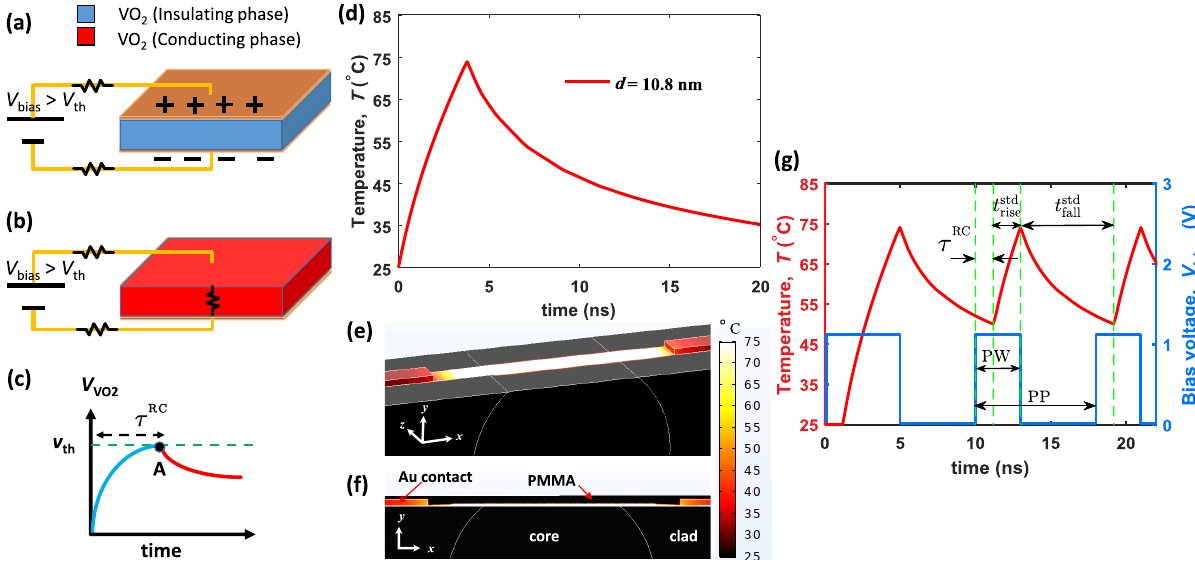
Figure 7: Modulation speed calculation. (a) The circuit model and phase-state of the device after applying the bias voltage before RC time < V ≥ V delay of the device, i.e. V , and (b) after RC time delay of the device, i.e. V . (c) The voltage-time diagram of the voltage on the VO 2 th VO 2 th VO layer after applying the bias voltage. (d) Temporal variation of the VO temperature between 25 ◦ C and 75 ◦ C during ICPT and CIPT for 2 2 d = 10 . 8 nm. (e) The 3D view of the spatial temperature distribution of the device at time = 4.2 ns. Here, PMMA is made transparent so that the temperature distribution of VO and Au contacts can be seen better. (f) 2D view of the device temperature distribution in the x − y plane. 2 (g) The steady-state operation of the TE modulator. The steady-state phase transition of VO and hence the switching between the on- and 2 off-states is induced by applying nanosecond electrical pulses with an amplitude 1.1 V, a width of PW = 2 . 98 ns, and a period of PP = 8 ns. = 1 . 8 ns and the cooling fall-time, t std = 6 . 17 ns and the time delay associated to the RC time constant of the The heating rise-time, t std rise fall device, 𝜏 RC = 1 . 18 ns are shown. In the steady-state operation the temperature of VO varies between the lower limit and the upper limit of 2 50 ◦ C and 75 ◦ C,